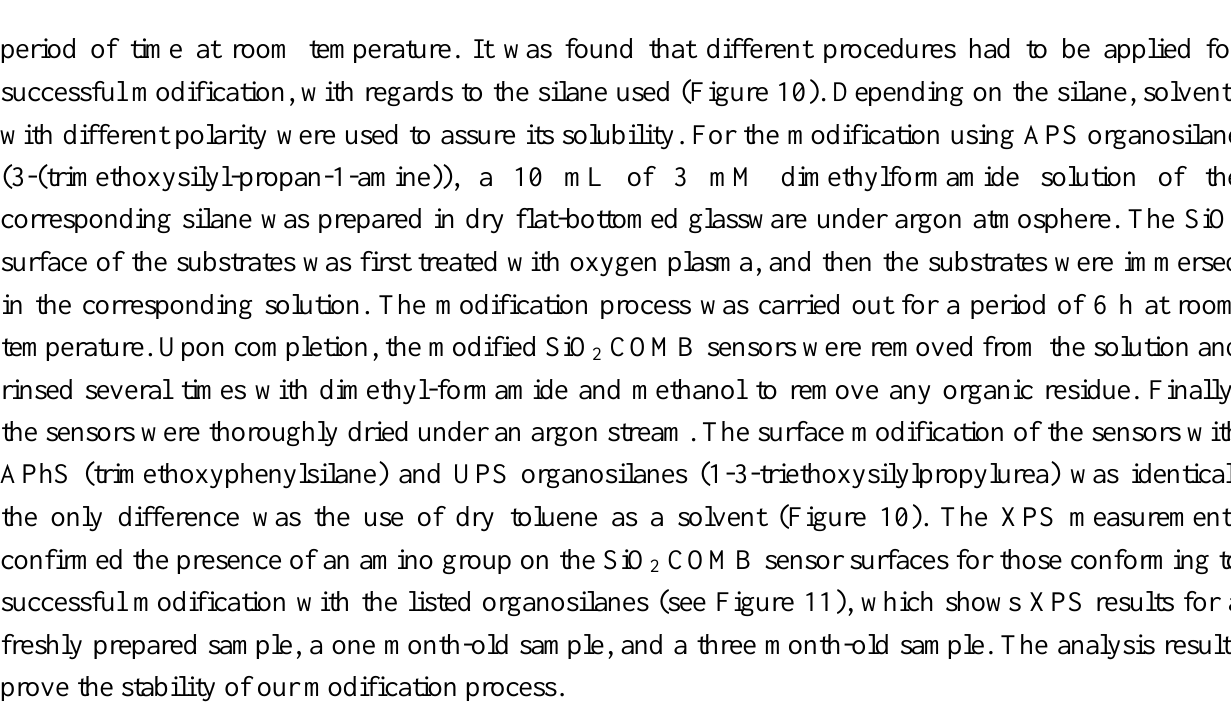
Figure 10. Chemical modification of SiO